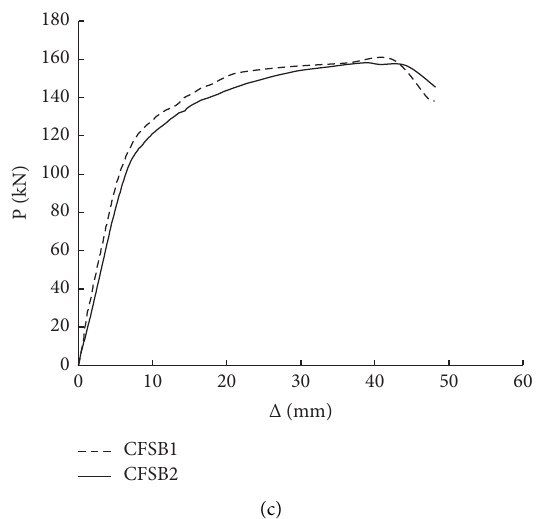
Figure 5: Relationship between load and deflection of steel beam. (a) Effect of prestressed CFRP sheet. (b) Effect of damaged level. (c) Effect of